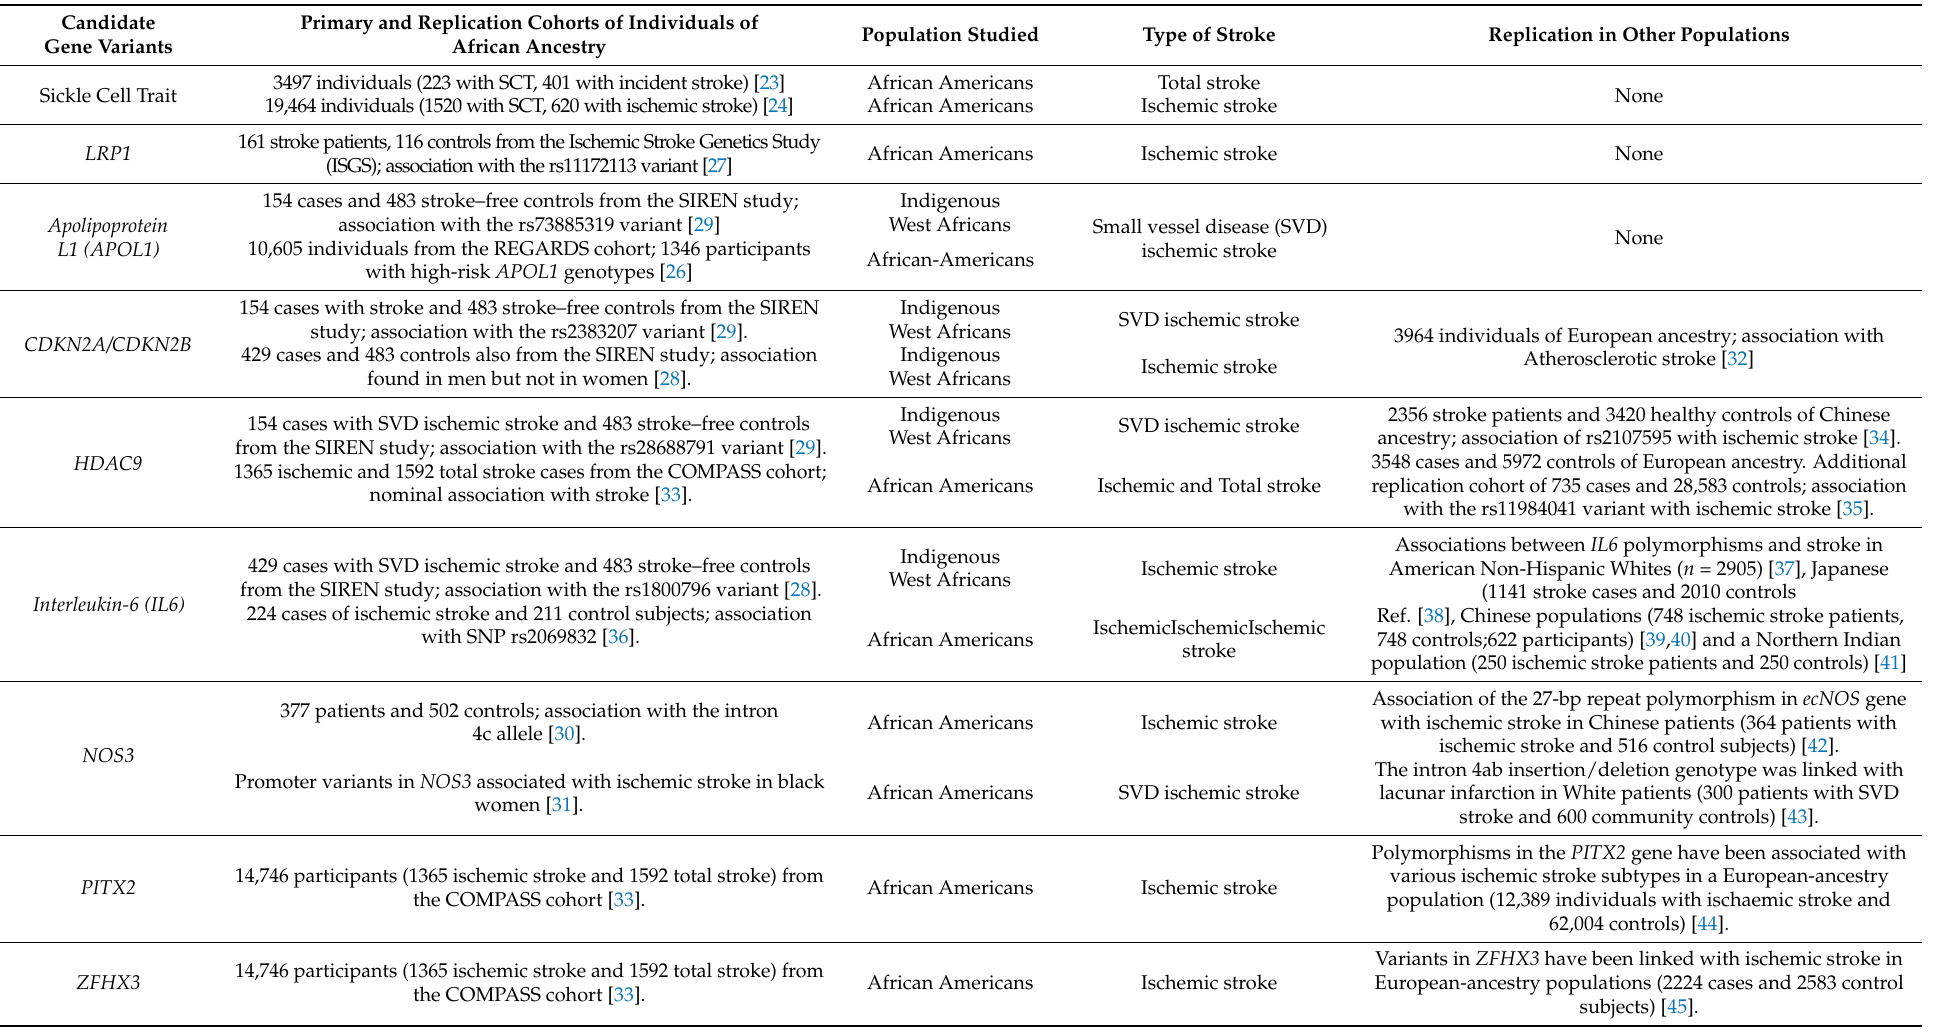
Table 1. Genes and alleles implicated in ethnic stroke